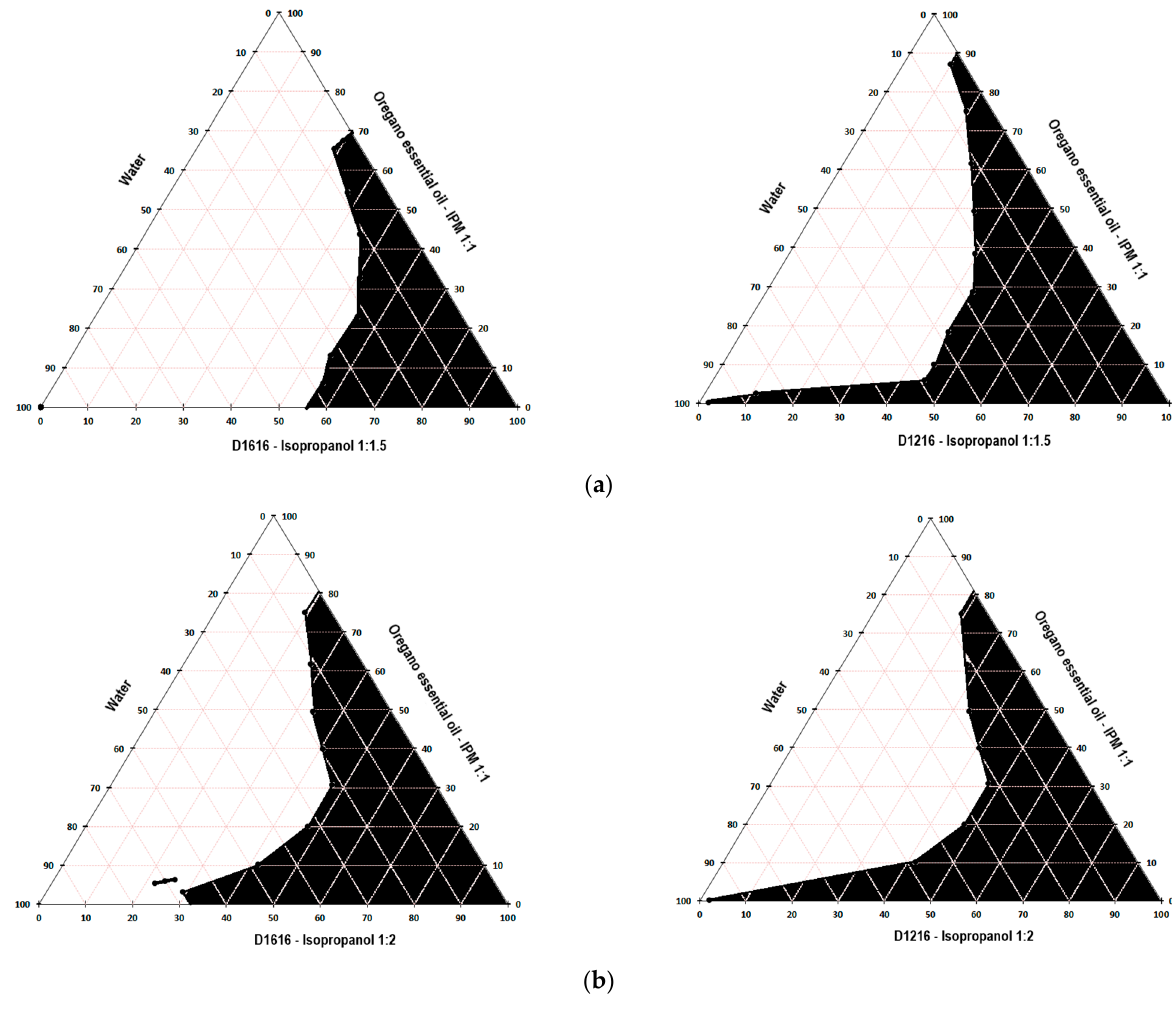
Figure 3. Pseudo-ternary phase diagrams for the oregano essential oil/IPM– D1616/IPA –water and oregano essential oil/IPM– D1216/IPA –water systems, for S mix 1:1.5 ( a ) and 1:2 ( b ). The black colored area marked in the diagrams represent the microemulsion region.